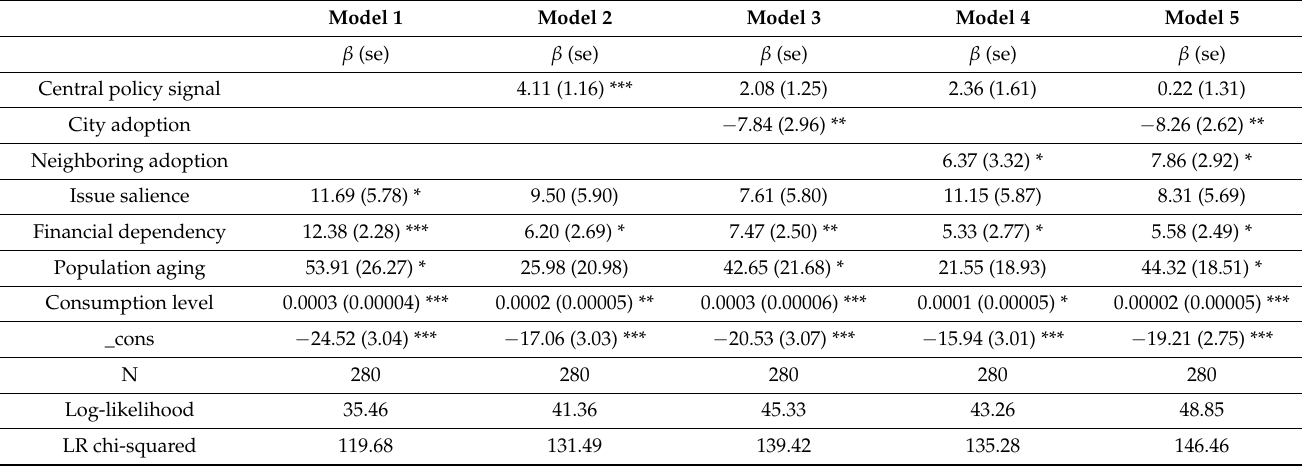
Table 3. Piecewise constant exponential models for EMDER policy adoption by provincial govern- ments in China. Model 1 Model 2 Model